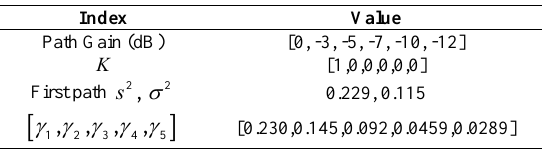
Table 1 the parameters of the modified 6-path SUI-3 channel